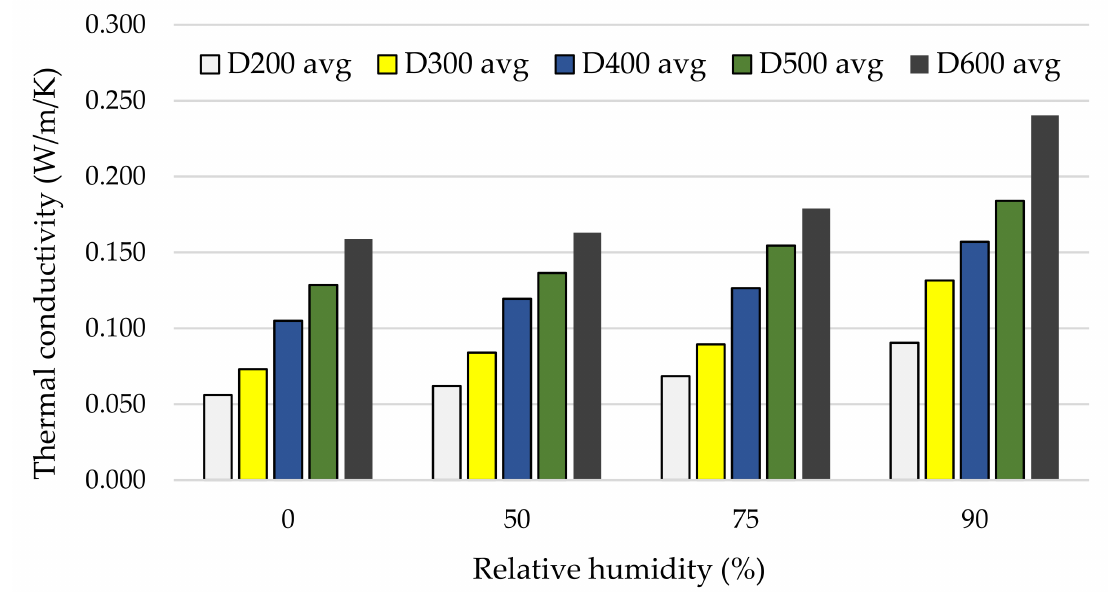
Figure 7. Average thermal conductivity of samples conditioned at different relative humidity